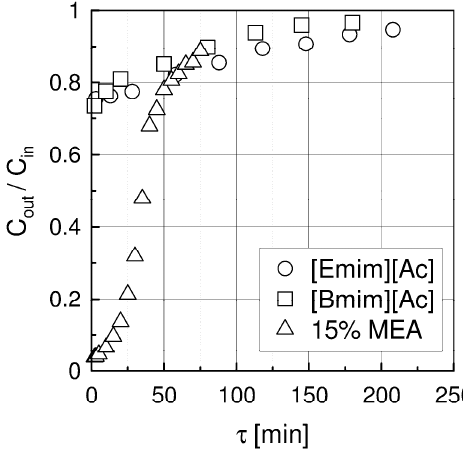
Figure 2. Comparison of outlet CO 2 concentrations for [Emim][Ac], [Bmim][Ac] and 15% wt. MEA at 1 bar, temperature 40 °C, Cin = 15% vol. and gas flow rate V g = 138 L/h. The measured initial outlet CO 2 concentration Cout/Cin are: 0.035, 0.721 and 0.754 for MEA solution, [Bmim][Ac] and [Emim][Ac], respectively. The time needed to reach outlet CO 2 concentration Cout = 15% vol. is about 80 min for MEA solution and 210 min for [Emim][Ac] and [Bmim][Ac]. The influence of absorption temperature and flows direction on outlet CO 2 concen- tration is of minor effect.